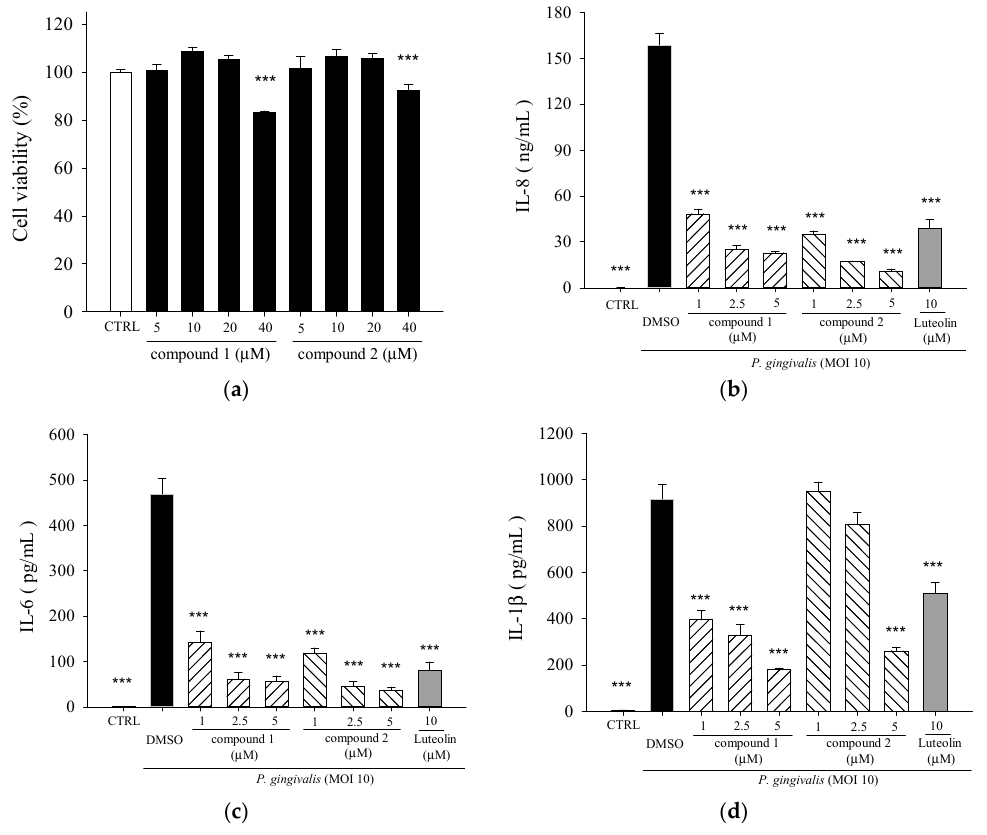
Figure 4. Effects of 5 β ,19-epoxycucurbita-6,23-diene-3 β ,19,25-triol ( 1 ) and 3 β ,7 β ,25-trihydroxycucurbita- 5,23-dien-19-al ( 2 ) on P. gingivalis -induced cytokines in THP cells. ( a ) Cell viability was determined